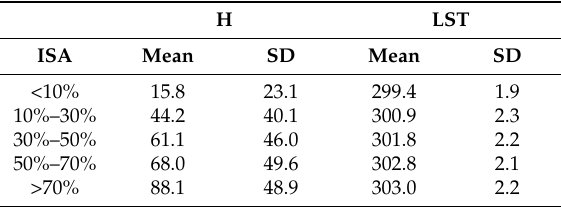
Table 6. Mean H and LST of percentage of ISA